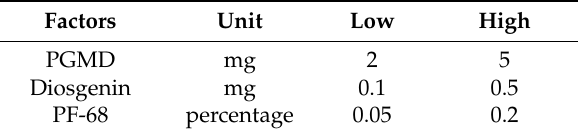
Table 1. Experimental factors taken for optimization of parameters for synthesis of diosgenin loaded PGMD